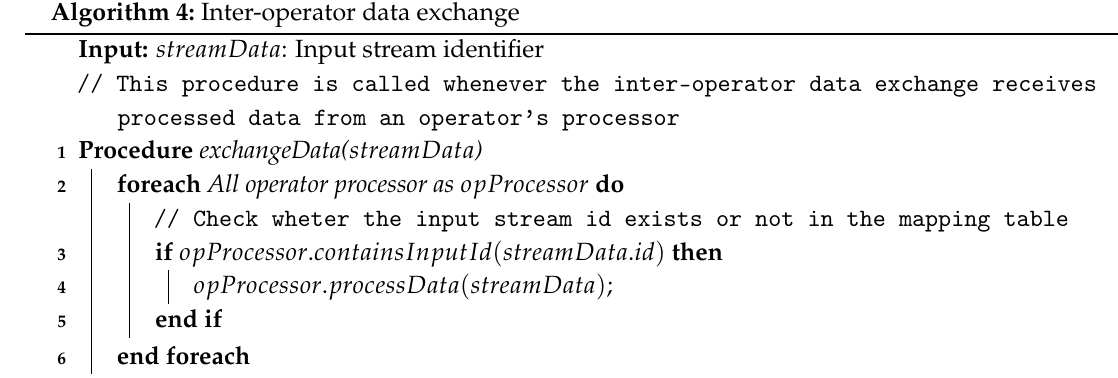
Algorithm 4: Inter-operator data